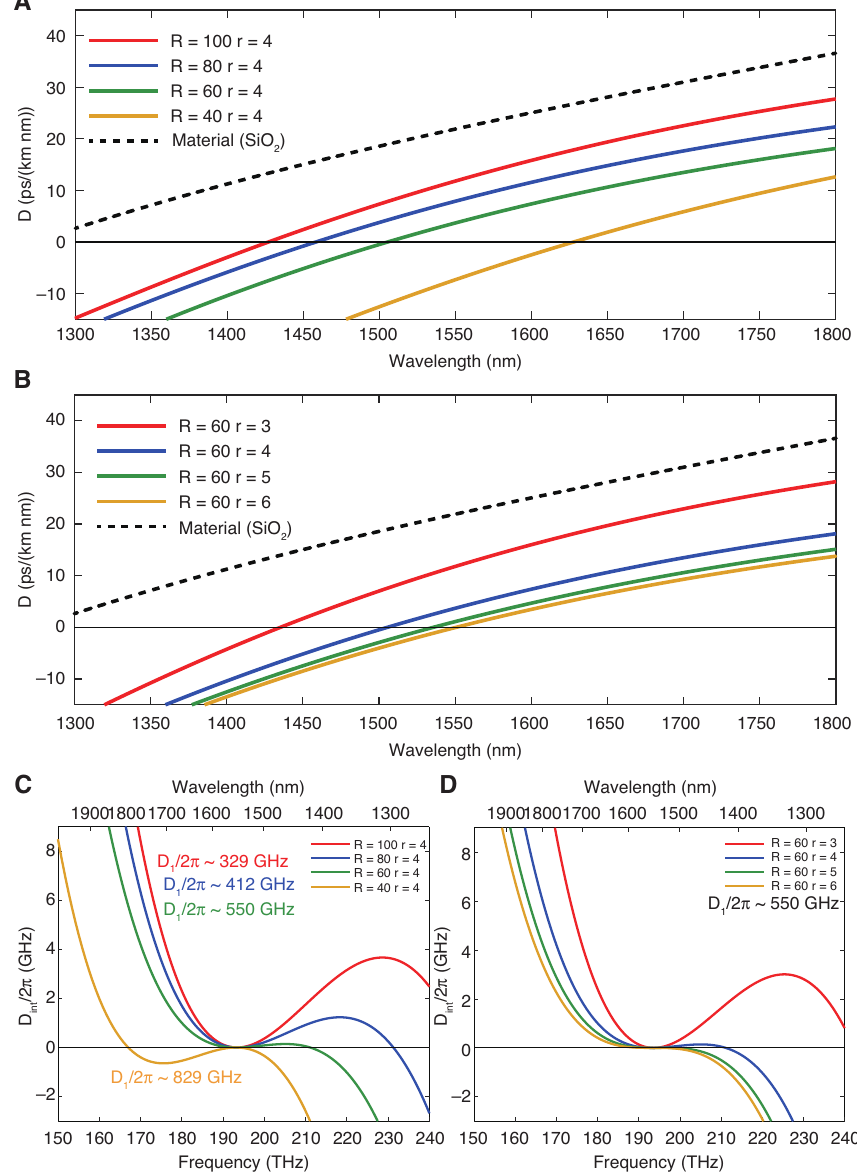
microtoroid for different resonator radii R and minor radii r in μ m. 2 for different minor int